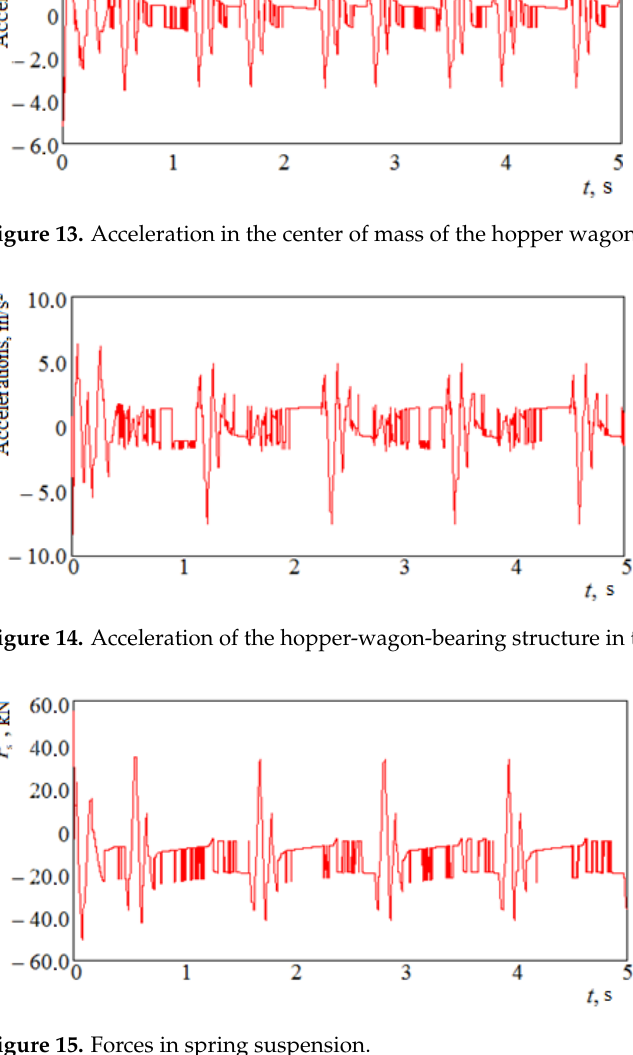
Figure 16. Coefficient of vertical dynamics.